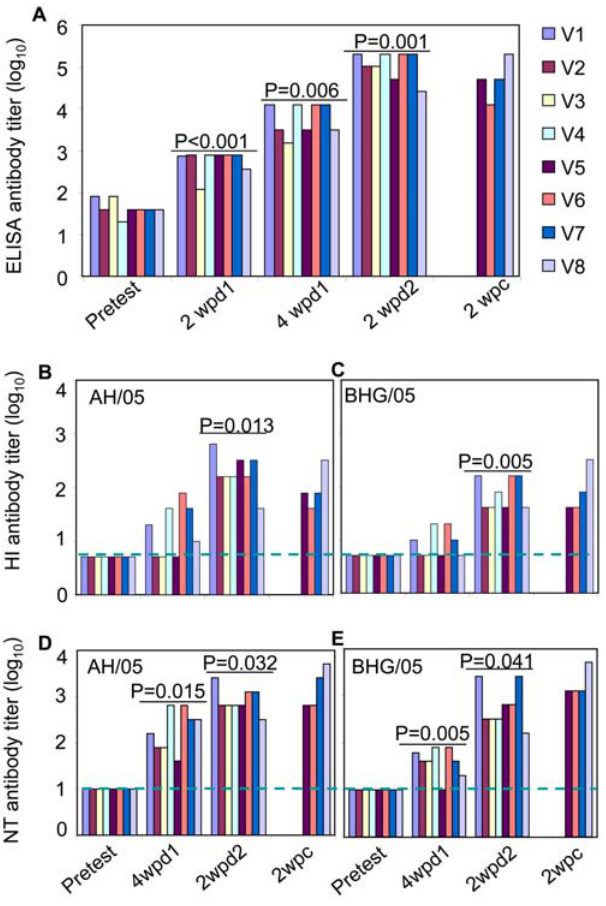
Figure 2. Antibody responses of nonhuman primates. (A) H5N1- specific antibody levels assessed by ELISA. Hemagglutination-inhibition (HI) antibody to AH/05 (B) and BHG/05 (C) with chicken erythrocytes, and microneutralization (NT) antibody to the AH/05 (D) and BHG/05 (E) viruses. The HI antibody titers with horse erythrocytes were 4- to 8-fold higher than those with chicken erythrocytes (data not shown). Titers are reported for individual vaccinated animals. Blue dashed lines indicate the lower limit of detection. Wpd1/2, week postvaccination dose 1 or 2; wpc, week postchallenge. The P values indicate the antibody titers with a significant increase from the preceding time point. In the control animals, the HI and NT antibodies at all time points are the same as the pretested values, only the ELISA antibody titers, ranged 400–800, were detected at two weeks postchallenge (data not shown).